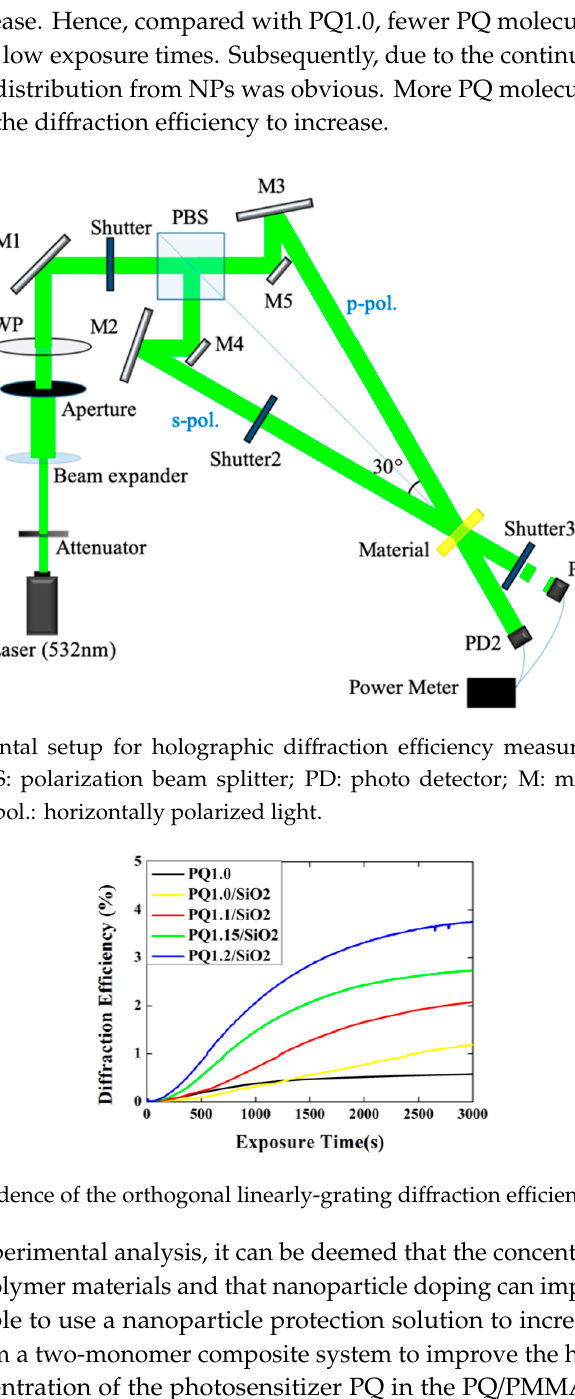
Figure 5. The dependence of the orthogonal linearly-grating diffraction efficiency on exposure time.